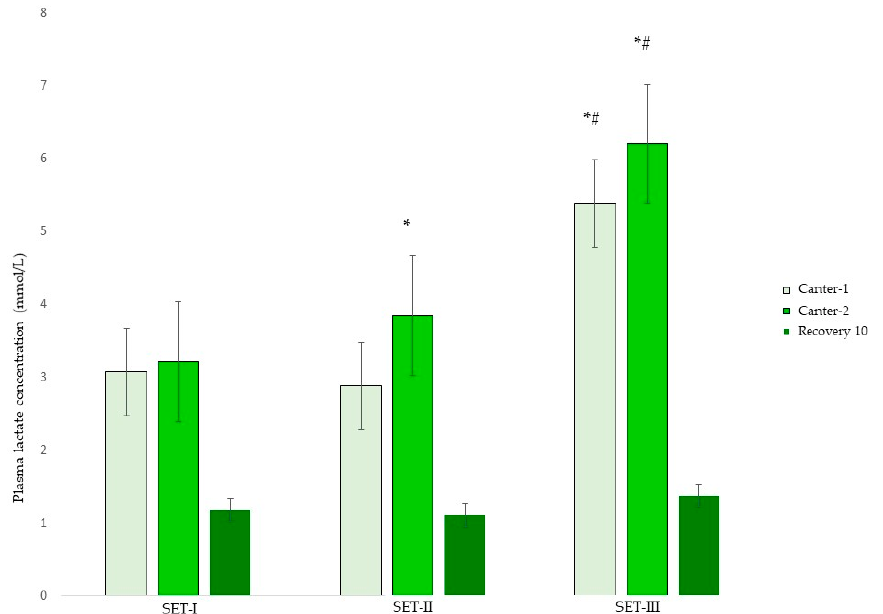
Figure 3. Mean ± SD plasma lactate concentration (LA) during three consecutive standardized exercise tests (SET-I, -II and -III) in young Friesian stallions with 5 (SET-I -SET-II) and 4 (SET-II–SET-III) weeks in between. * Indicating a statistical difference in LA per gait from SET-I; # indicating a statistical difference in LA per gait from